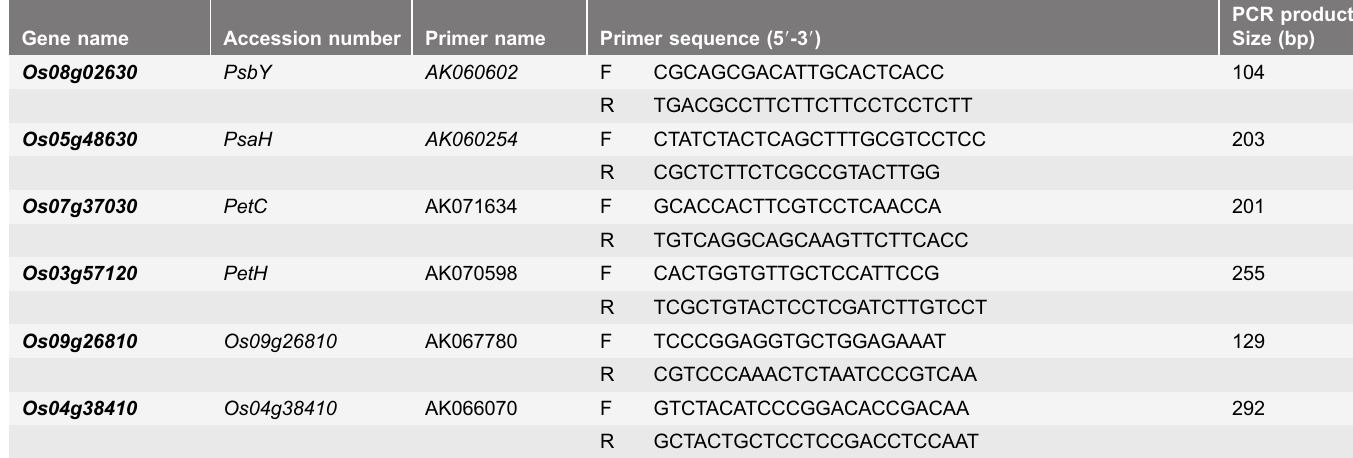
Table 2. The conserved region of gene sequence and predicted product size for PCR used for detecting gene expression in the leaves of